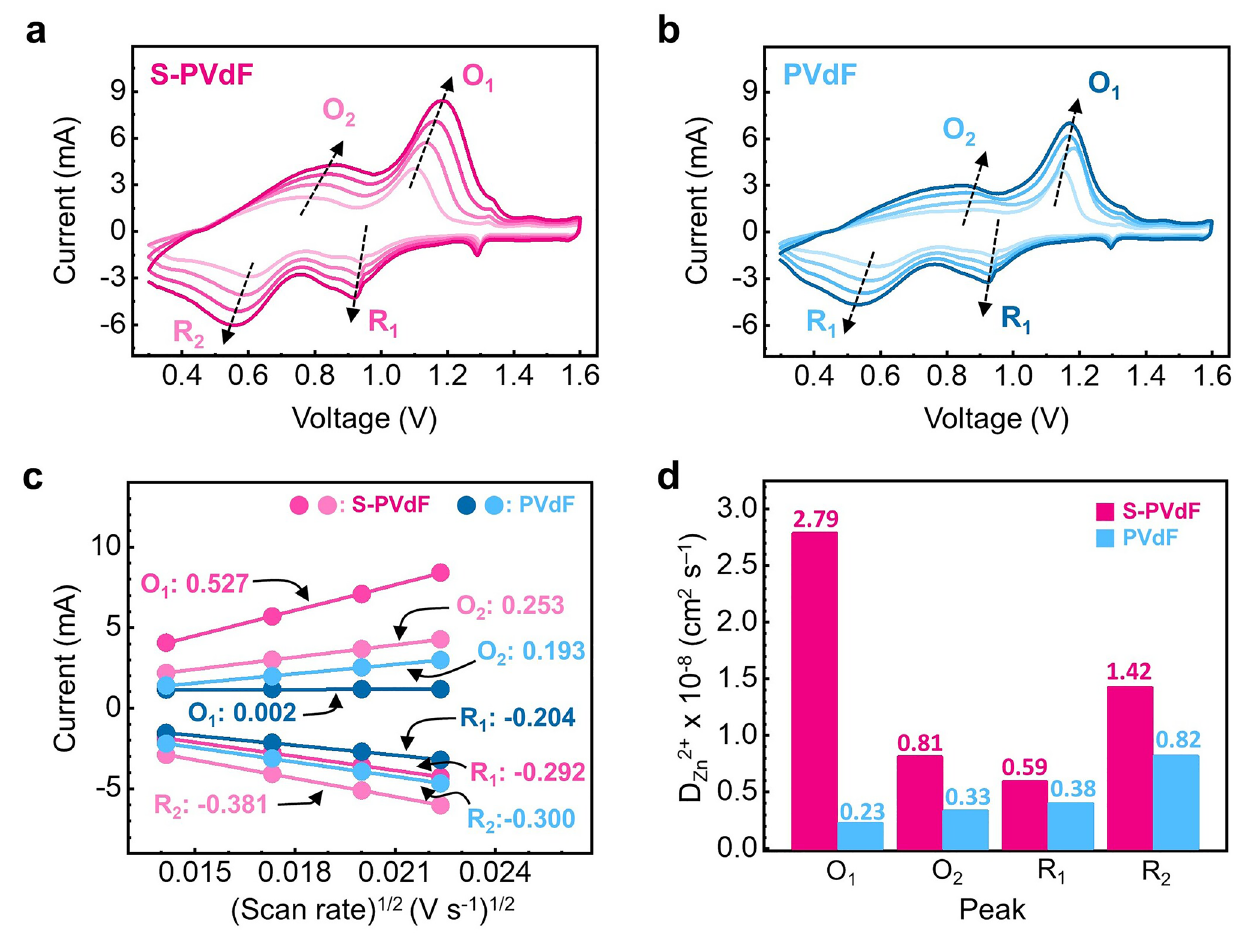
Fig. 3 CV profiles of full cells with a S-PVdF and b PVdF binders at different scan rates (0.2 − 0.5 mV s −1 ). c Plots of normalized peak currents versus square root of scan rates for full cells with S-PVdF and PVdF binders S. d Calculated D